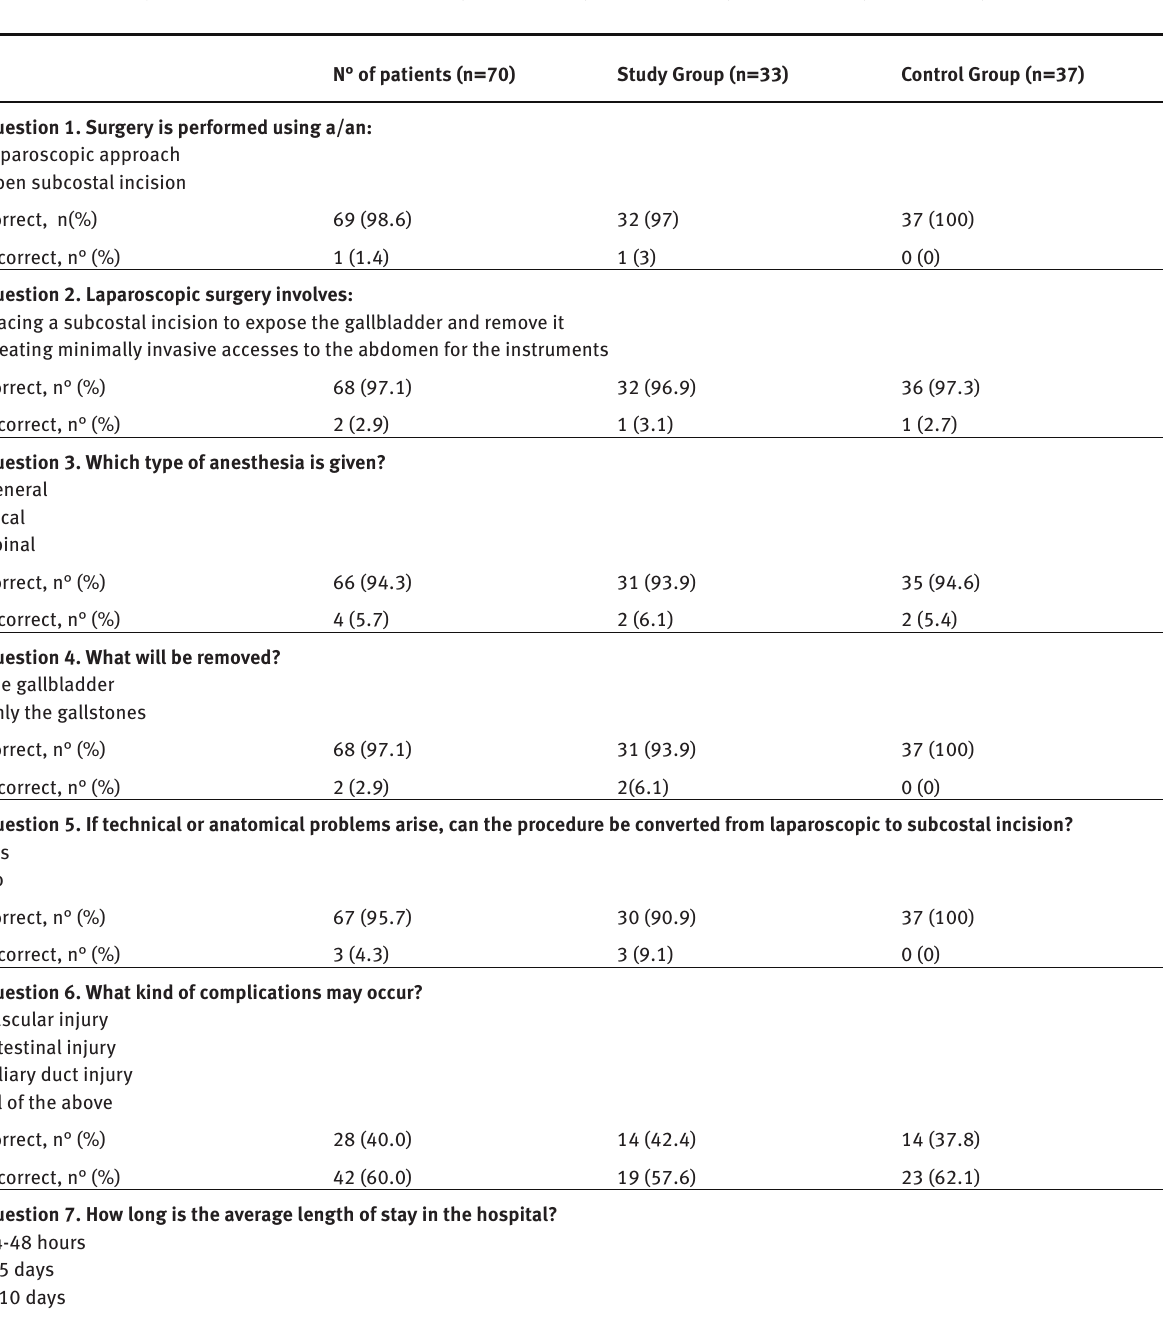
Table 2: Feedback questionnaire items and number and percentage of patients who responded correctly or incorrectly.